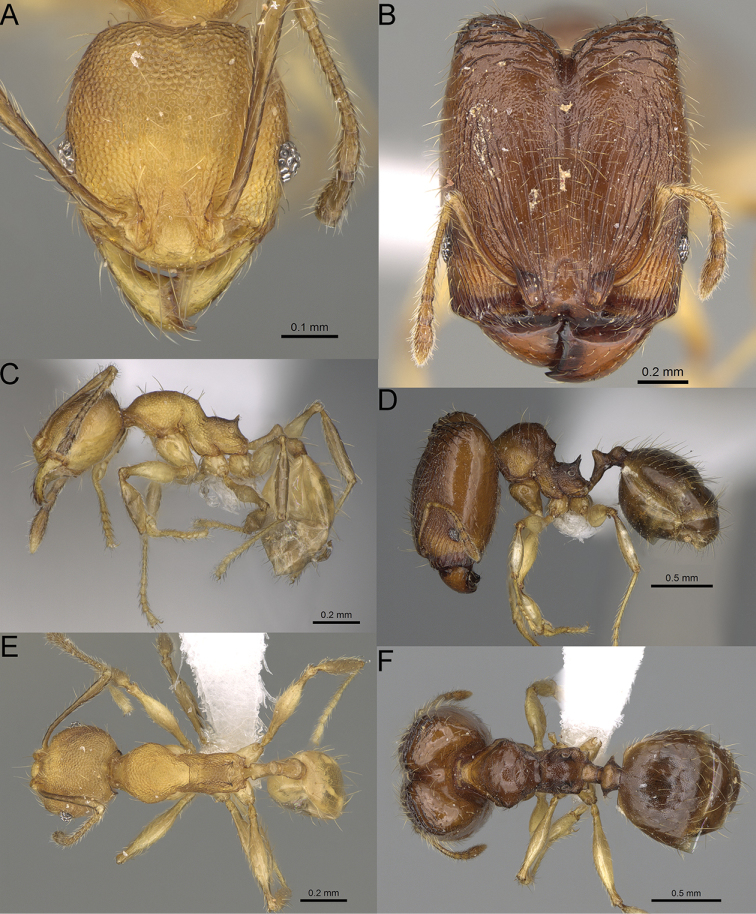
Pheidole
fitarata sp. nov., full-face view (A), profile (C), and dorsal view (E) of paratype minor worker (CASENT0420025) and full-face view (B), profile (D), and dorsal view (F) of holotype major worker (CASENT0420028).